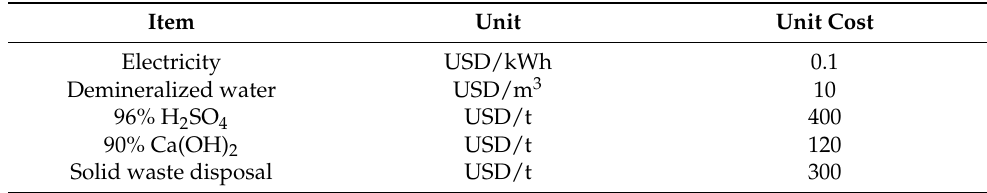
Table 8. Unit costs of the considered sources. The price of electricity reflects the situation in the Czech Republic. Item Unit Unit Cost